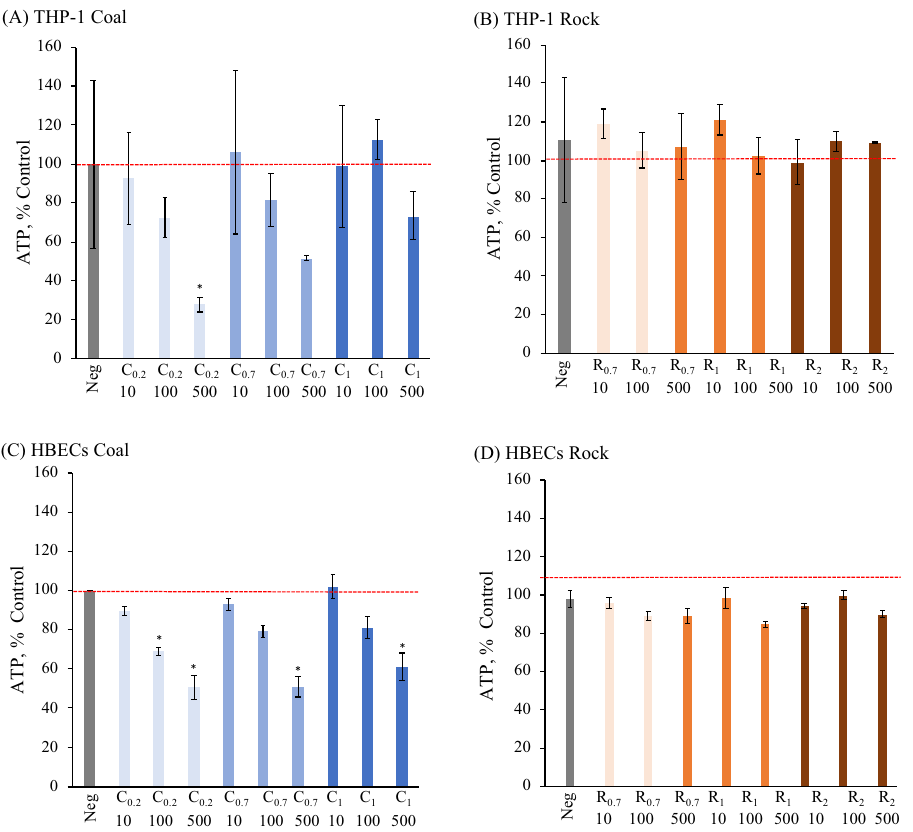
Figure 4. ATP analysis for ( A , B ) THP-1 cells and ( C , D ) HBECs of various coal and rock treatments (10, 100, 500 µg/ml) ( p <